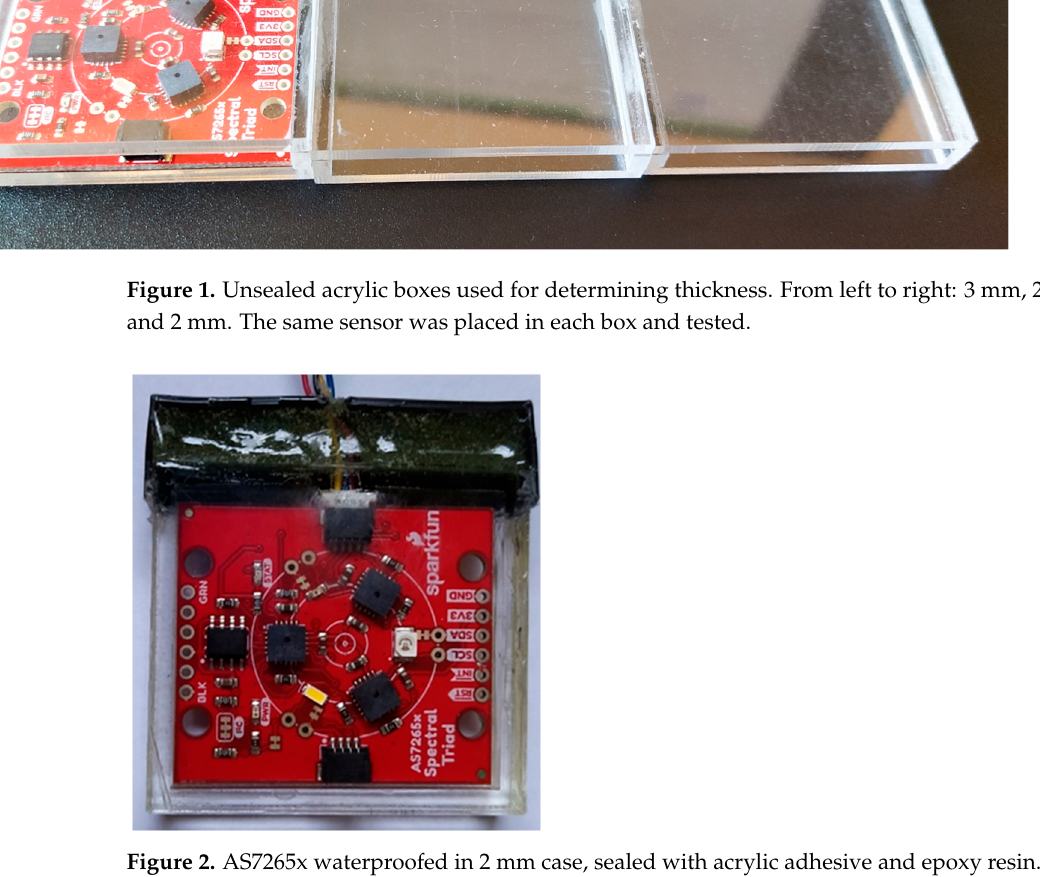
Figure 2. AS7265x waterproofed in 2 mm case, sealed with acrylic adhesive and epoxy resin.